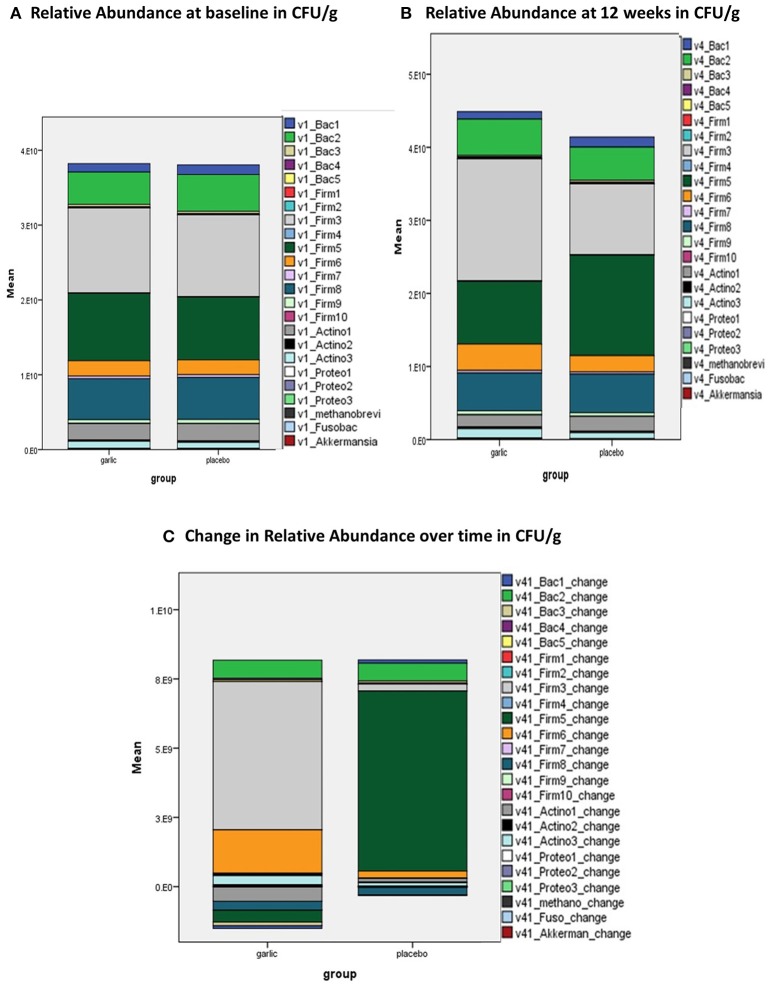
Relative Abundance in CFU/g at (A) baseline; (B) 12 weeks; and (C) change over time by group (garlic vs. placebo). CFU/g, colony forming units per gram stool; v1, visit 1, baseline; v4, visit 4, 12 weeks; Bac 1, Bacterioidetes-Prevotella group; Bac 2, Bacteroides vulgatus; Bac 3, Barnesiella spp.; Bac 4, Odoribacter spp.; Bac 5, Prevotella spp.; Firm 1, Anaerotruncus colihominis; Firm 2, Butyrivibrio crossotus; Firm 3, Clostridium spp.; Firm 4, Coprococcus eutactus; Firm 5, Faecalibacterium prausnitzii; Firm 6, Lactobacillus spp.; Firm 7, Pseudoflavonifractor spp.; Firm 8, Roseburia spp.; Firm 9 =; Ruminococcus spp.; Firm 10, Veillonella spp.; Actino 1, Bifidobacterium spp.; Actino 2, Bifidobacterium longum; Actino 3, Collinsella aerofaciens; Proteo 1, Desulfovibrio piger; Proteo 2, Escherichia coli; Proteo 3, Oxalobacter formigenes; Methanobrevi, Methanobrevibacter smithii; Fusobac, Fusobacteriim spp.; Akkermansia, Akkermansia muciniphila.